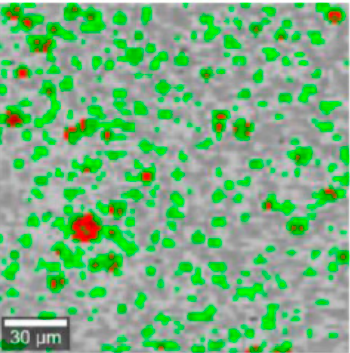
Figure 6. Raman maps (20× resolution) of F3L prepared “de novo” microparticles formulations. Red and green correspond to the API and lipids, respectively.